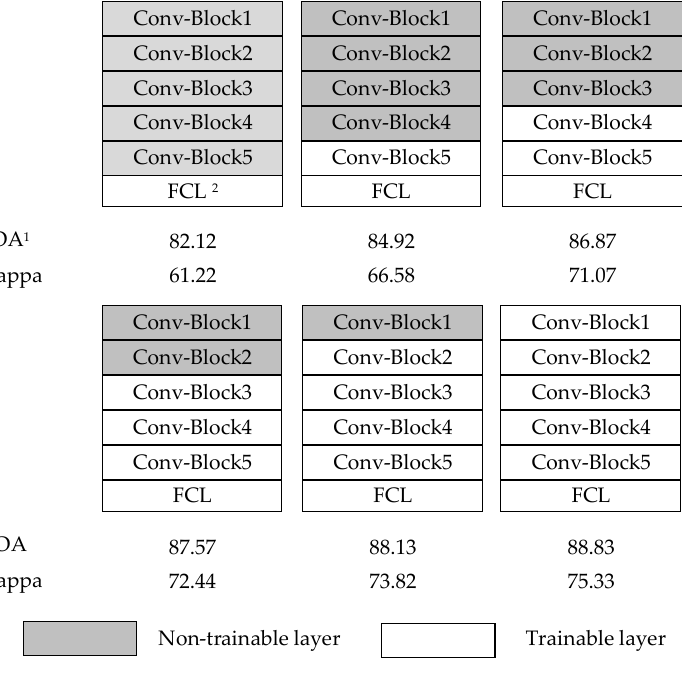
Figure 5. Fine-tuning of different layers. 1 Overall accuracy; 2 Fully-connected layer.